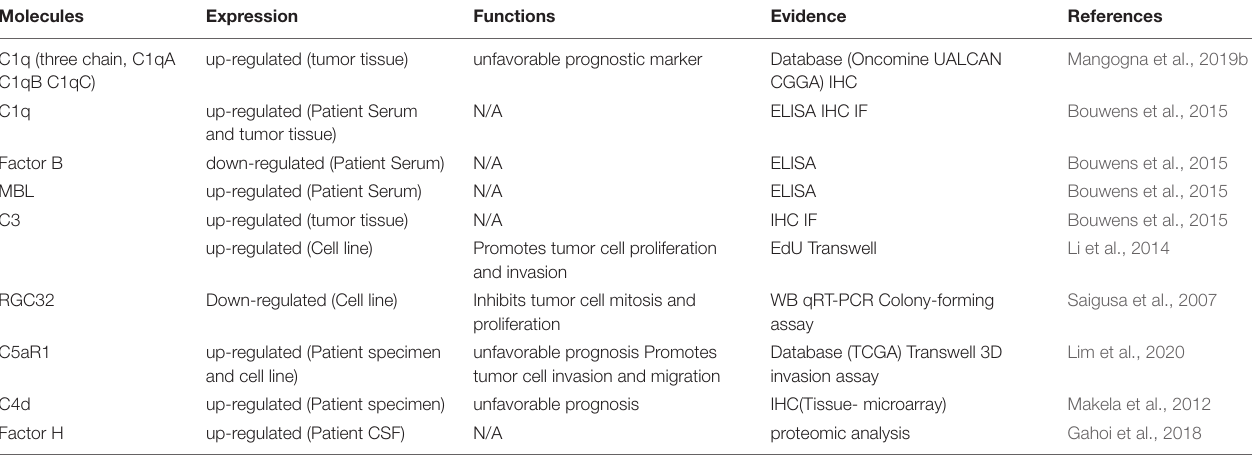
TABLE 2 | Complement components in